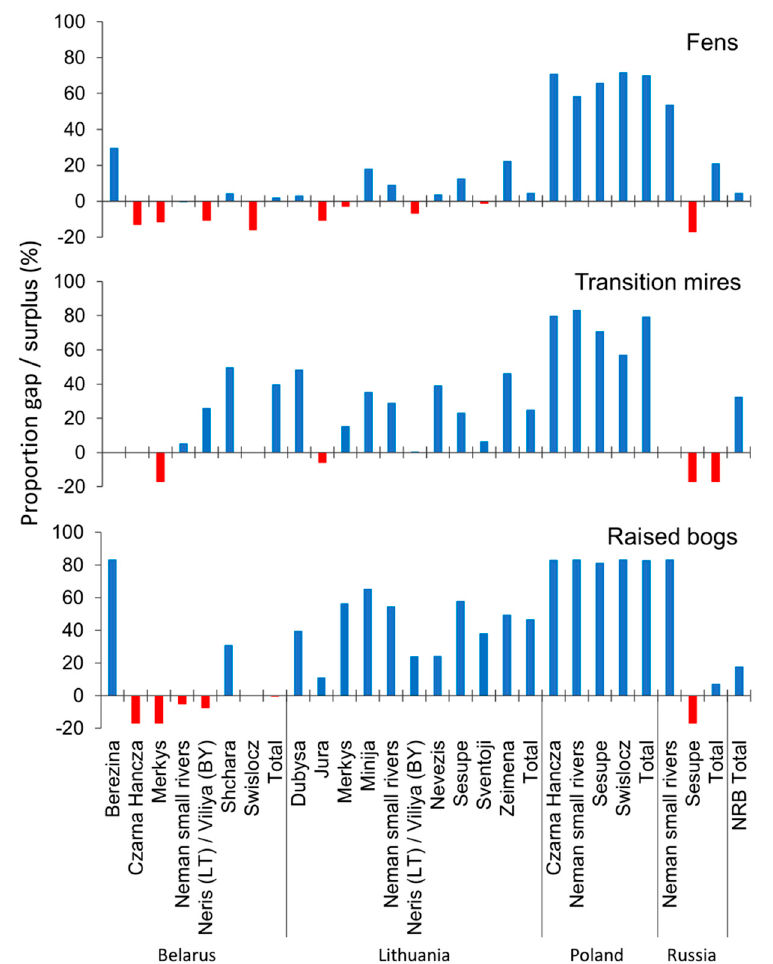
Figure 5. Regional distribution of peatland protection gaps and surpluses for each country by the Neman Rivers’ sub-basins. In addition, the overall protection gap/surpluses are contained in the Neman River basin Total. Values equalling more than zero indicate the protection surplus in area proportion, values below zero indicate a gap in the protection of peatlands base on the Convention of Biological Diversity target #11 (17% protection).